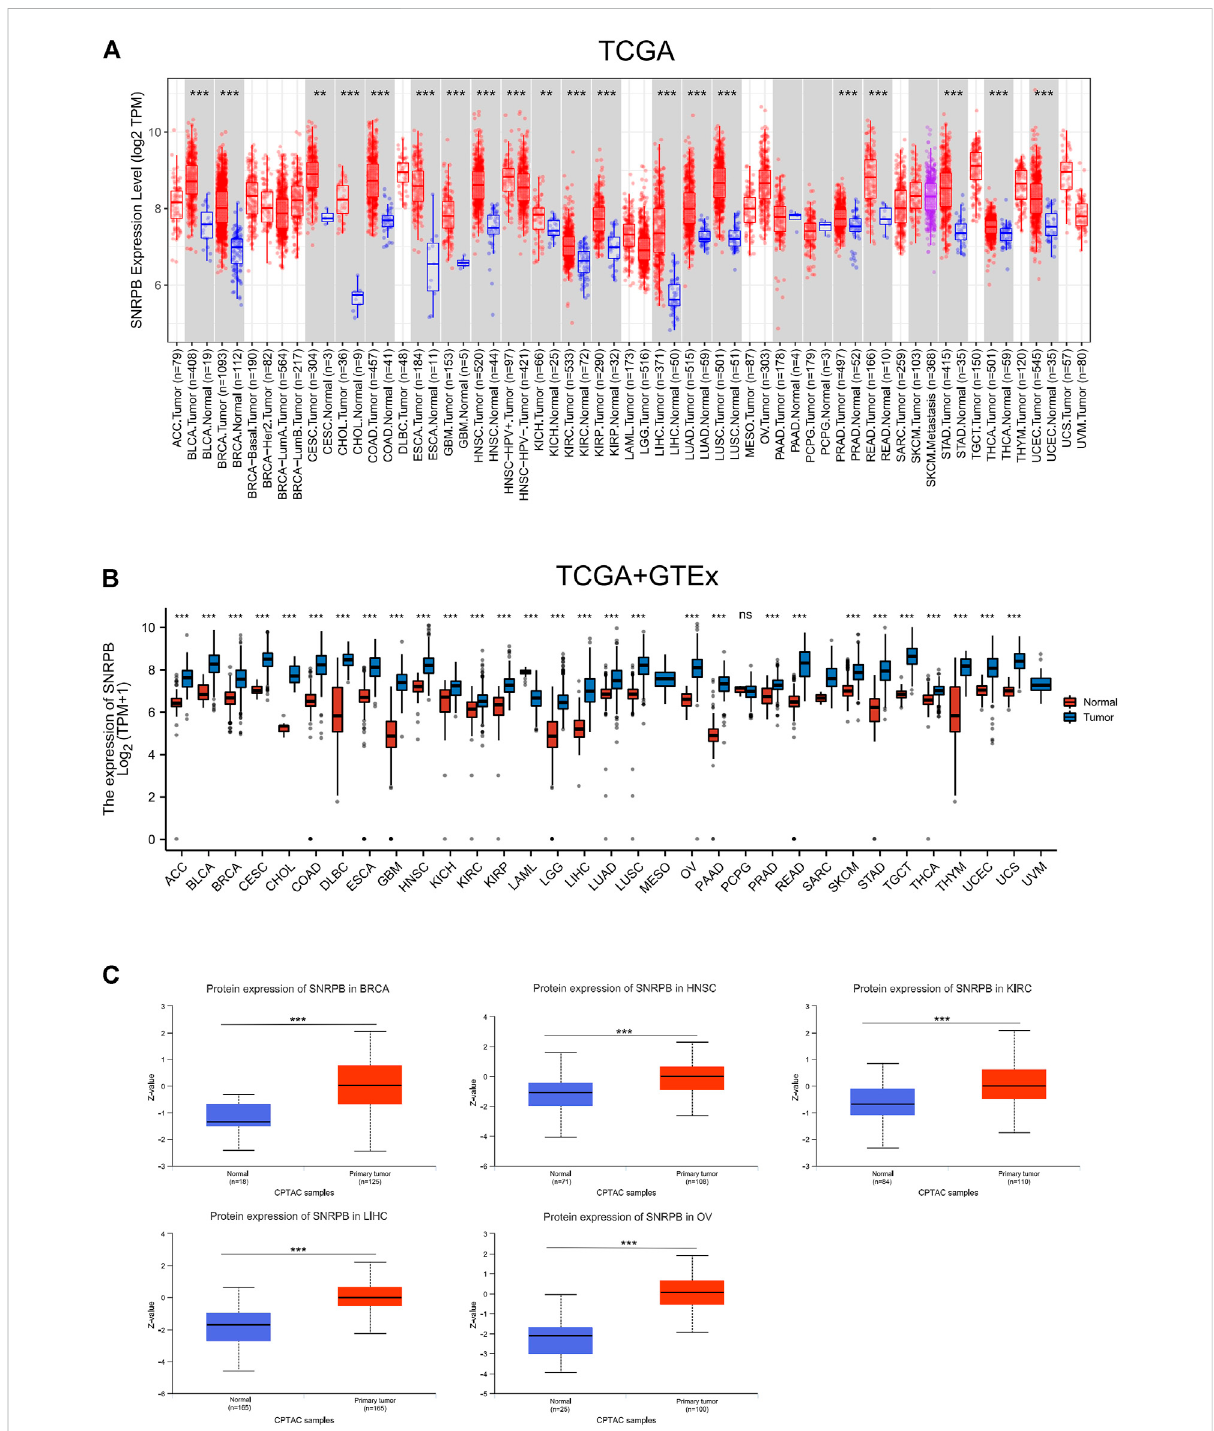
FIGURE 1 mRNA and protein expression levels of SNRPB across tumors. (A) mRNA expression level of SNRPB in tumors and adjacent paracancerous tissues in TCGA from TIMER2. (B) mRNA expression level of SNRPB in tumors and the corresponding normal tissues in TCGA and GTEx. (C) . Protein expressionlevelofSNRPBinprimarytumorsandthecorrespondingnormaltissuesintheCTPACdatasetfromUALCAN.ns,nosigni fi cantdifference; *, p < 0.05; **, p < 0.01; ***, p <